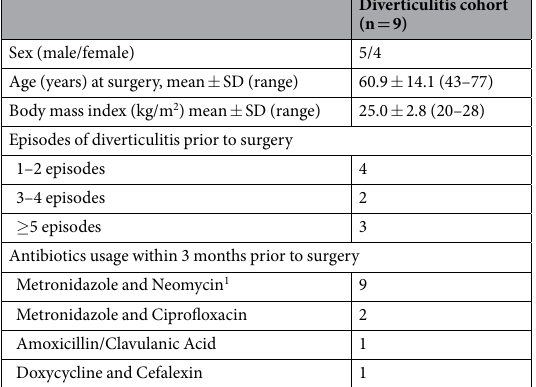
Table 1. Demographics and clinical information. SD, standard deviation. 1 Received day prior to surgery as part of mechanical bowel